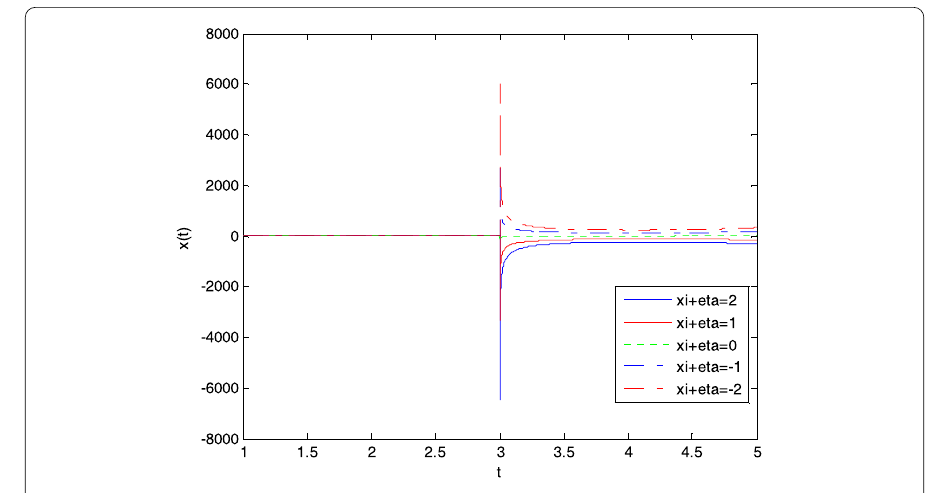
Figure 12 The solution trajectory of system (5.3) with ρ = 2